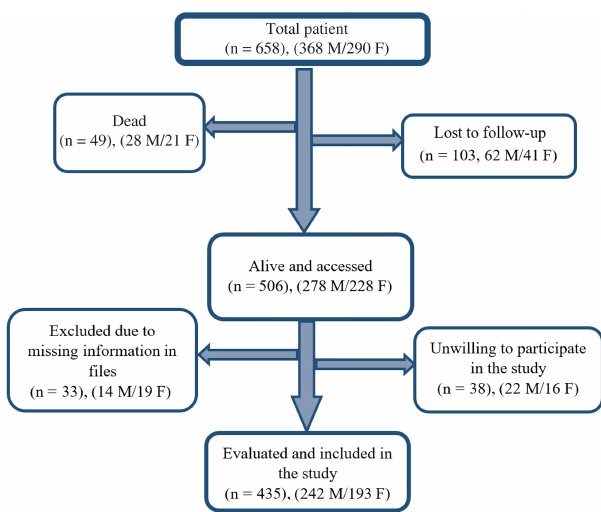
Figure 1. Patient flow chart. M, male; F,